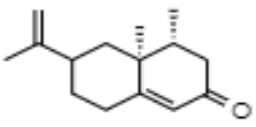
Figure 1. Structure of nootkatone (NKT).